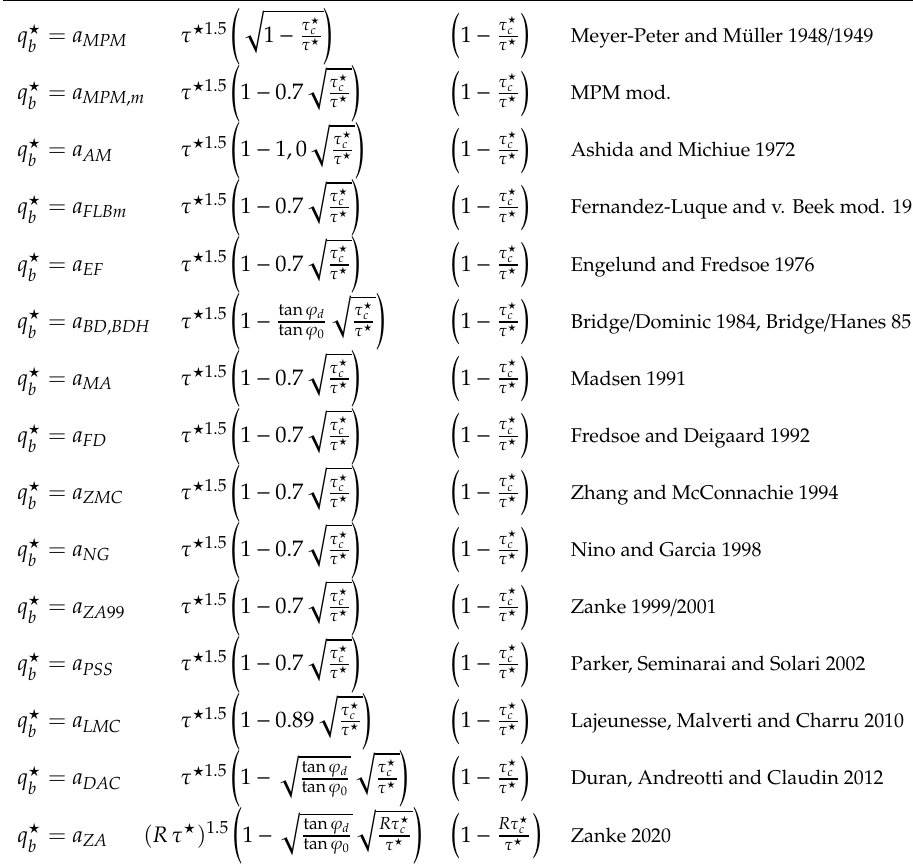
Table 1. The 13 bed-load transport formulas with similar or identical